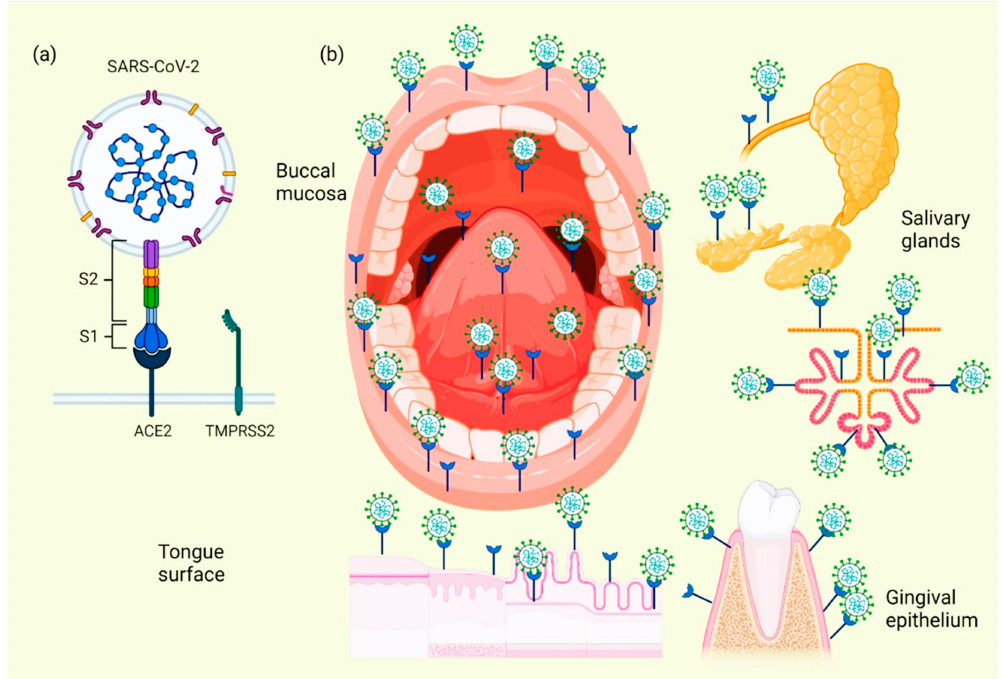
Figure 2. Location of ACE2 on oral cavity and its interaction with the SARS-CoV-2. Binding between the SARS-CoV-2 S protein and the ACE2 protein allows entry of the coronavirus, which subsequently allows its replication and the immediate activation of a possible innate immune response against the virus, including the infiltration of a myriad of immune cells and the subsequent production of many proinflammatory cytokines. This triggers the manifestation of symptoms and signs in the oral cavity of patients with COVID-19 ( a ). Various spaces and surfaces in the oral cavity where the virus and its receptors are detected, such as the oral mucosa, periodontal tissues, salivary glands, and tongue ( b